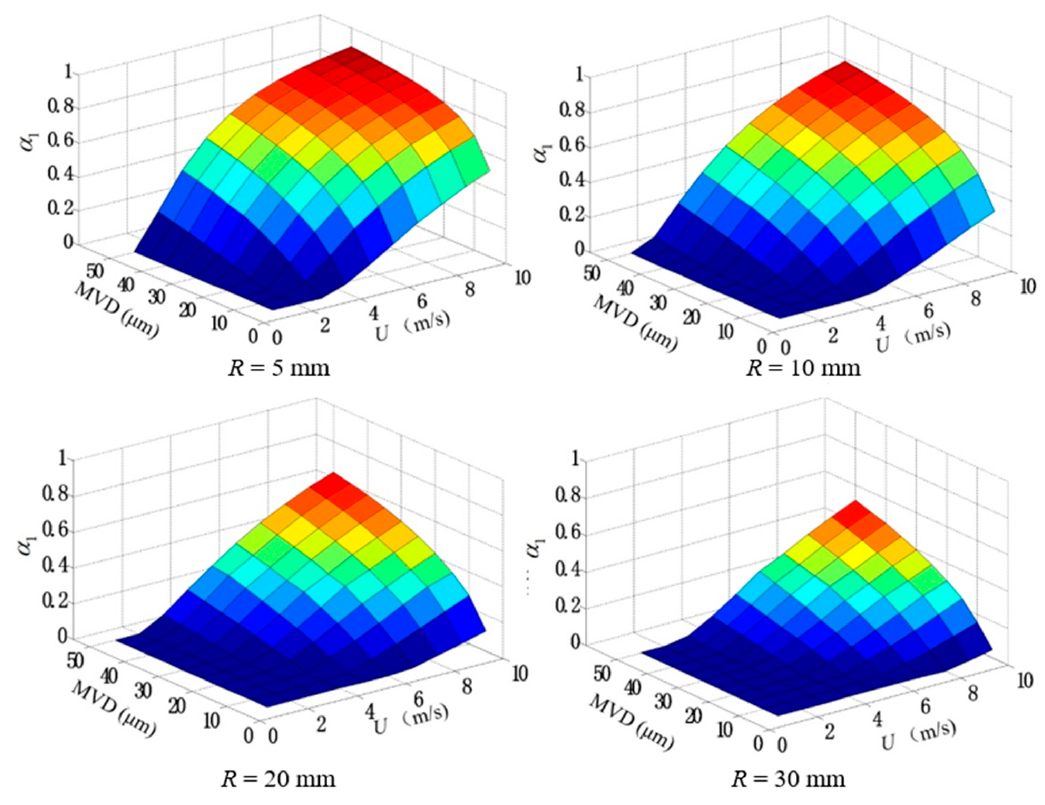
Figure 2. Collision efficiencies of four conductors with different radii under different median volume diameters (MVD) and wind speeds.